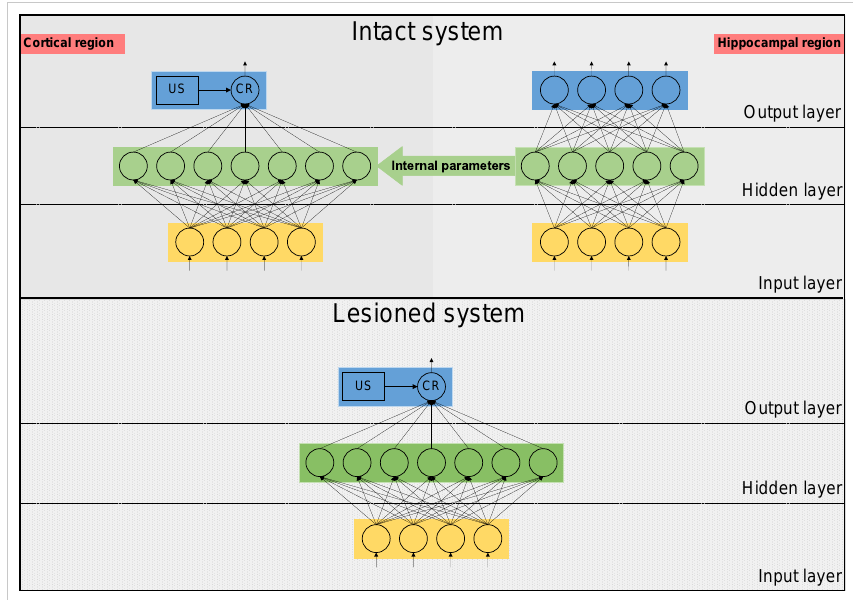
Figure 3. Intact and lesioned systems of the CHCQ model.